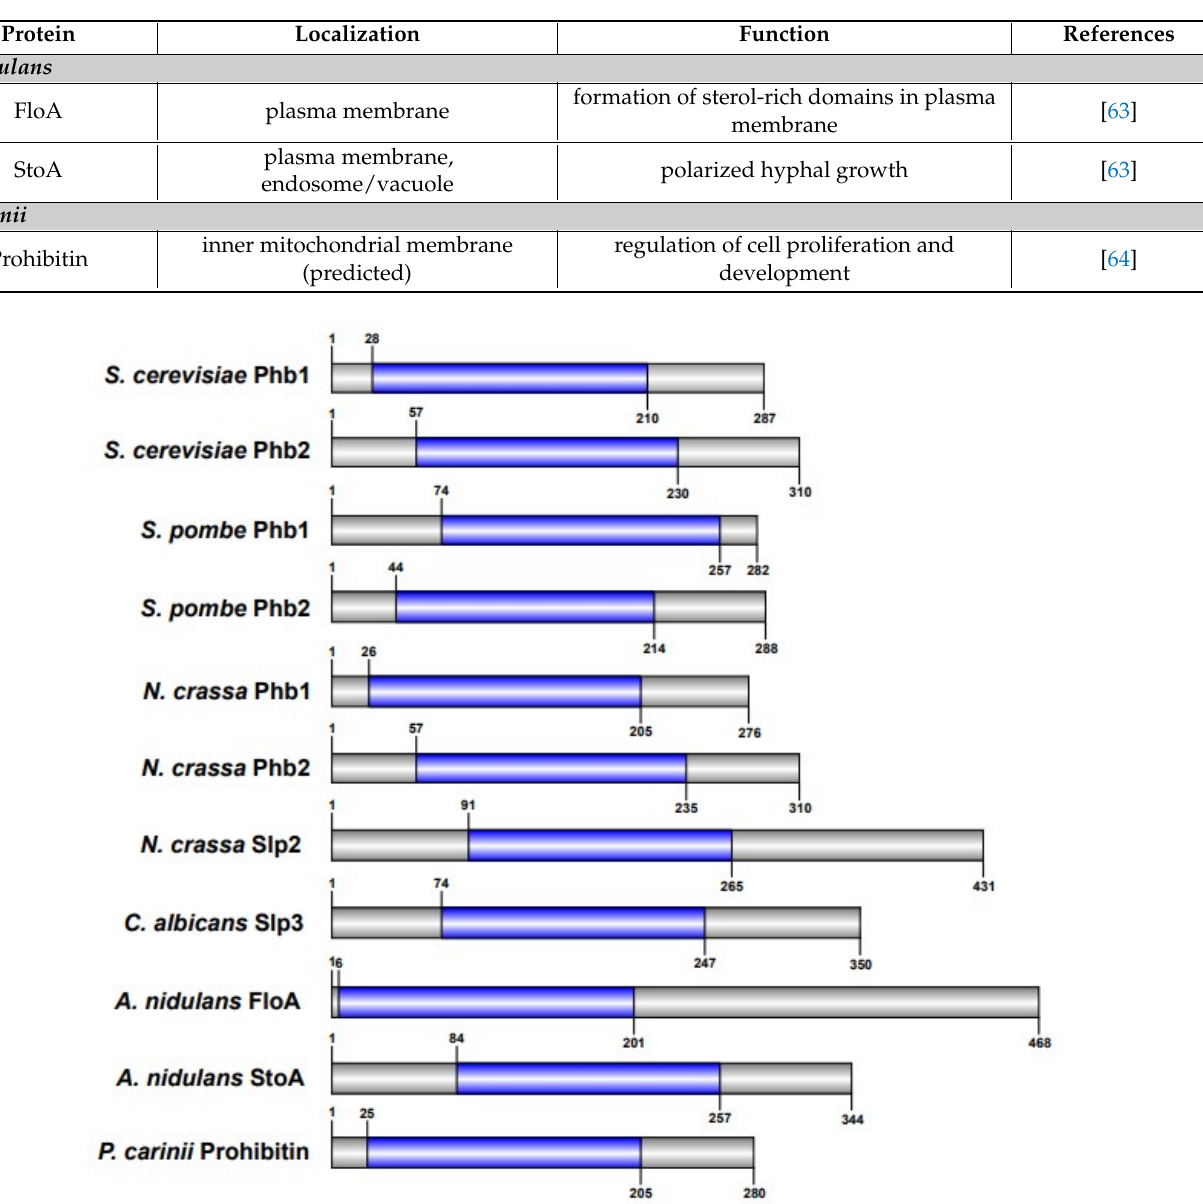
Figure 3. Schematic of fungal SPFH proteins. SPFH proteins that have been experimentally validated in fungi are depicted. Sequences for each protein were obtained from the Saccharomyces Genome Database, PomBase, Candida Genome Database, Aspergillus Genome Database, or UniProt [59,65,66]. SPFH/Band 7 domains (blue) were identified using InterProScan [67]. Schematics were constructed and drawn to scale using Illustrator for Biological Sequences [68].